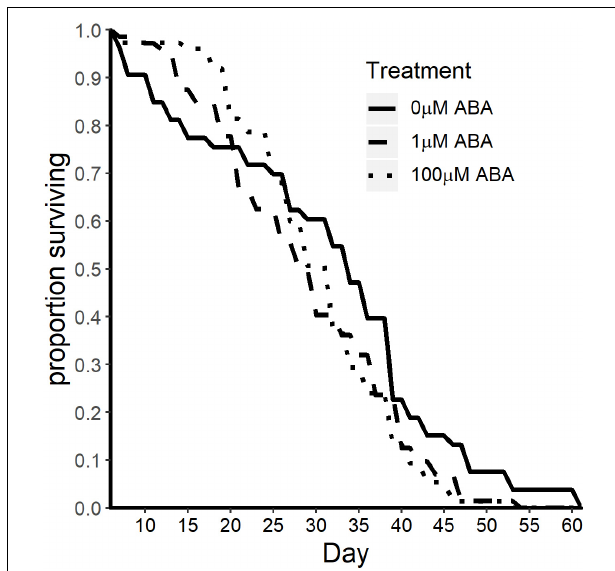
FIGURE 7 | ABA treatment of larval A. stephensi reduced adult female survival. Survival curves of adult female mosquitoes derived from control untreated larvae and larvae treated with 1 µ M ABA (log-rank p = 0.028) and 100 µ M ABA (two-stage p = 0.025). Median survival was reduced from 34 ± 14.2 days in controls to 28 ± 10.78 days (1 µ M ABA) and to 30 ± 14.22 days (100 µ M ABA). Data are representative of two biological